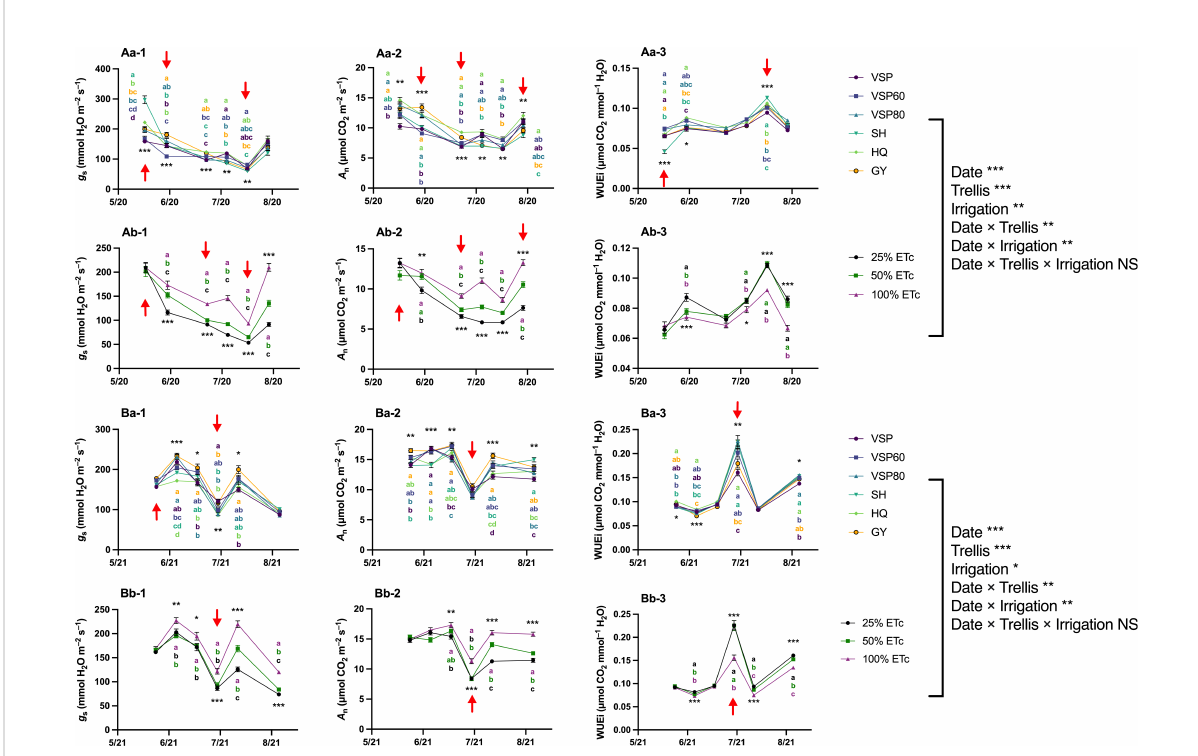
FIGURE 4 Progression of Leaf Gas Exchange as Affected by Trellis Systems and Applied Water Amounts of ‘ Cabernet Sauvignon ’ in Oakville, CA, USA in (A) 2020 and (B) 2021; (a) the main effect of trellis systems, (b) the main effect of applied water amounts; (1) stomatal conductance ( g s ), (2) net carbon assimilation rate ( A n ), (3) intrinsic water use ef fi ciency (WUE i ). Error bars represent one standard deviation from the mean, letters represent ranking after Tukey ’ s post hoc analyses. Asterisks represents signi fi cant levels p , ‘ *** ’ p < 0.001, ‘ ** ’ p < 0.01, ‘ * ’ p < 0.05. Arrows above individual dates indicate statistical difference between starting date and the indicated date. VSP, vertical shoot position; VSP60, vertical shoot position 60°; VSP80, vertical shoot position 80°; SH, single hire wire; HQ, High-Quadrilateral; GY, guyot-pruned vertical shoot position; ET c , crop evapotranspiration. ns, not signig fi